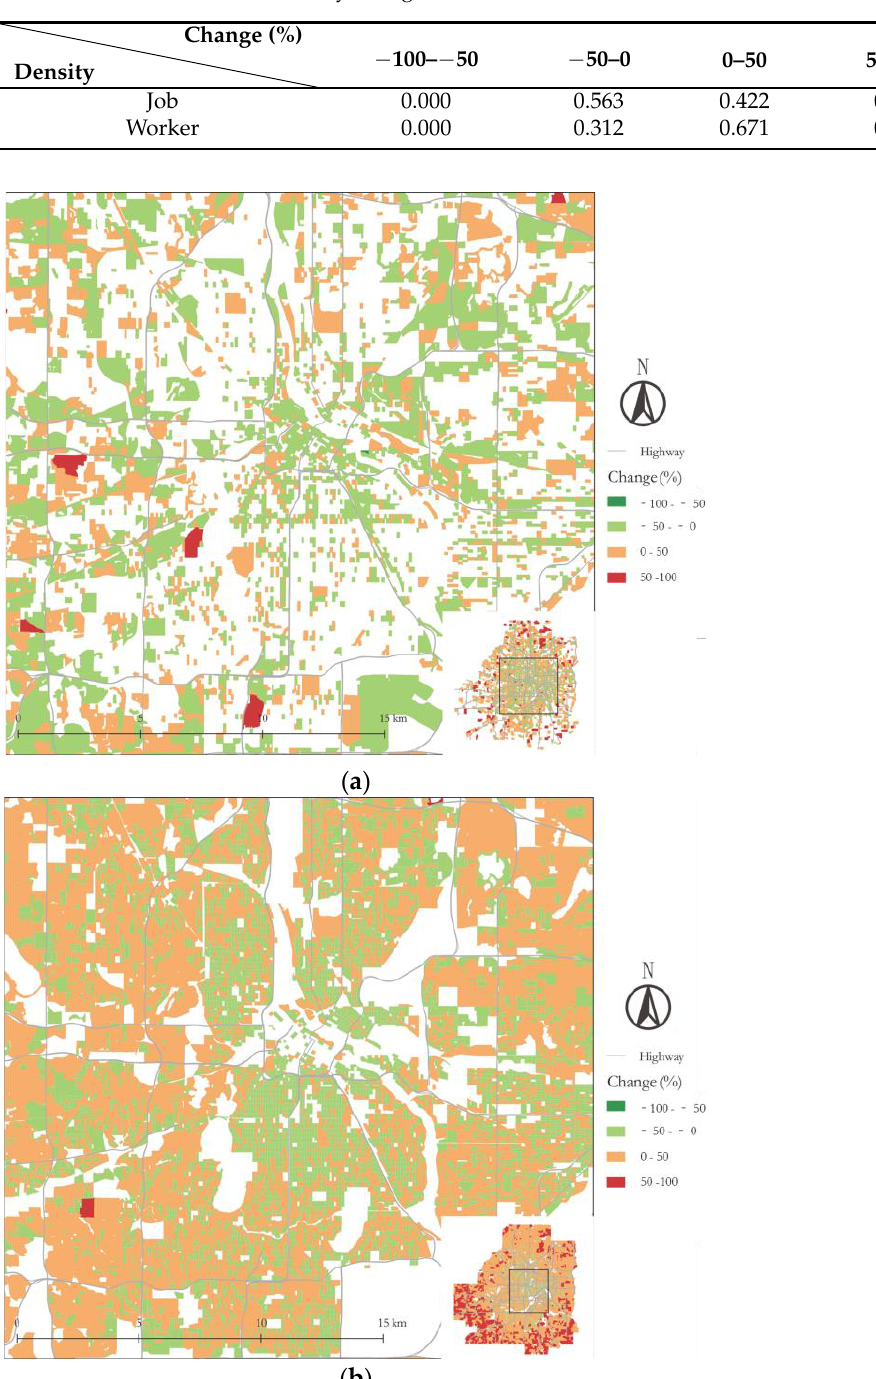
Table 5. The distribution of density changes between 2017 and 2022.